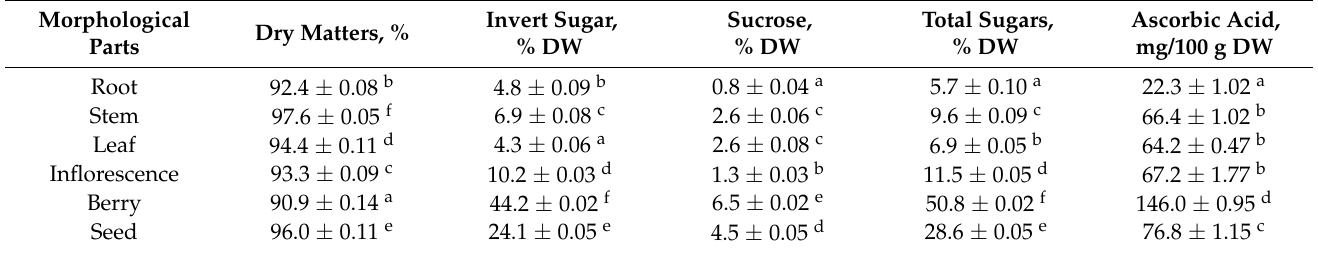
Table 1. Composition of dry matter, invert sugar, sucrose, total sugars, and ascorbic acid contents of A. cordata different morphological